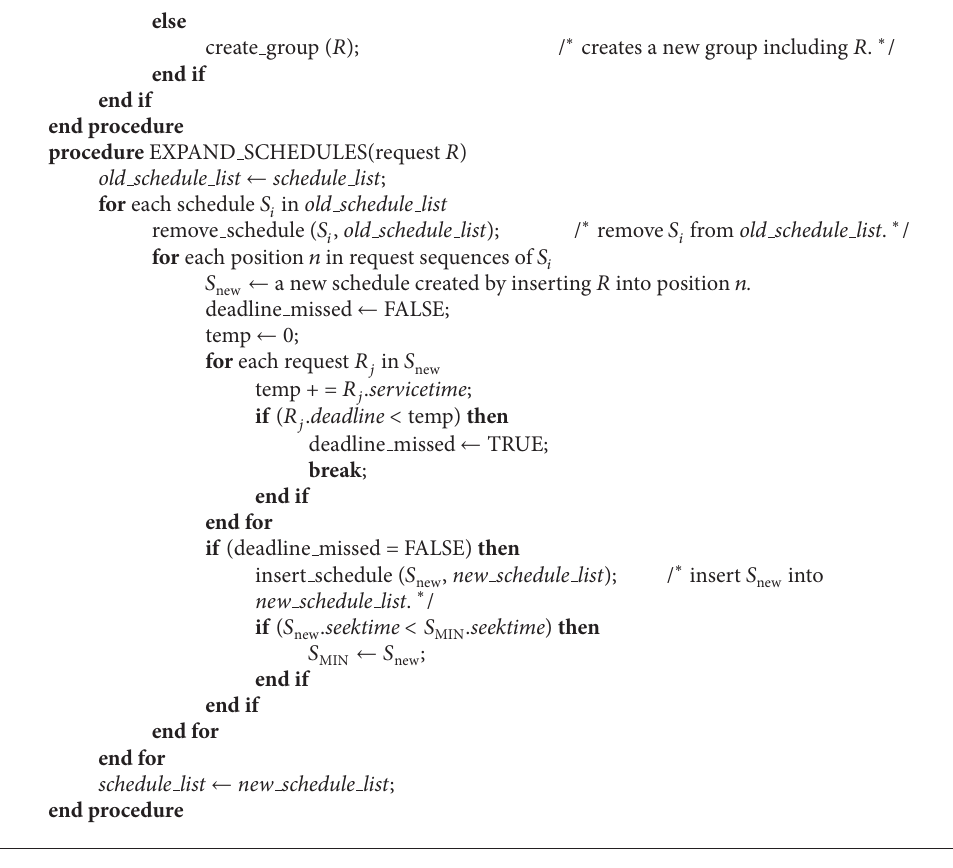
Algorithm 1: Inserting a request into queue.